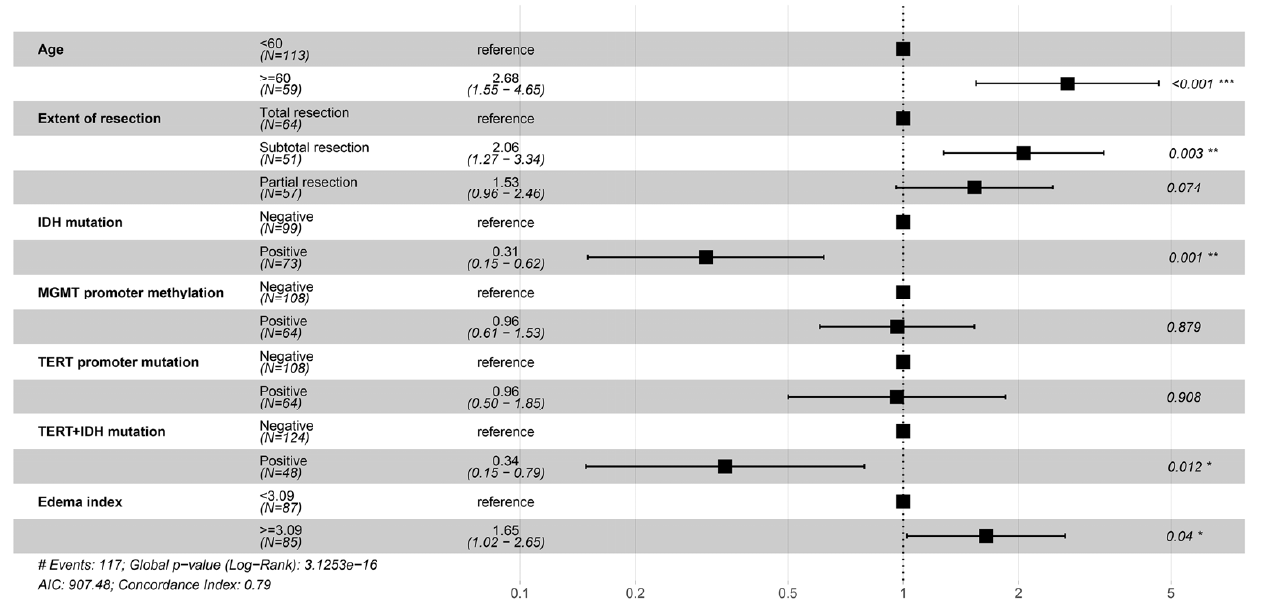
Figure 1. Forest plot for the multivariable COX analysis of PFS. Age, extent of resection, IDH mutation, IDH and TERT promoter co-mutation, and edema index were identified as the significant prog- nostic factors for PFS. * p < 0.05,** p < 0.01, *** p < 0.001.